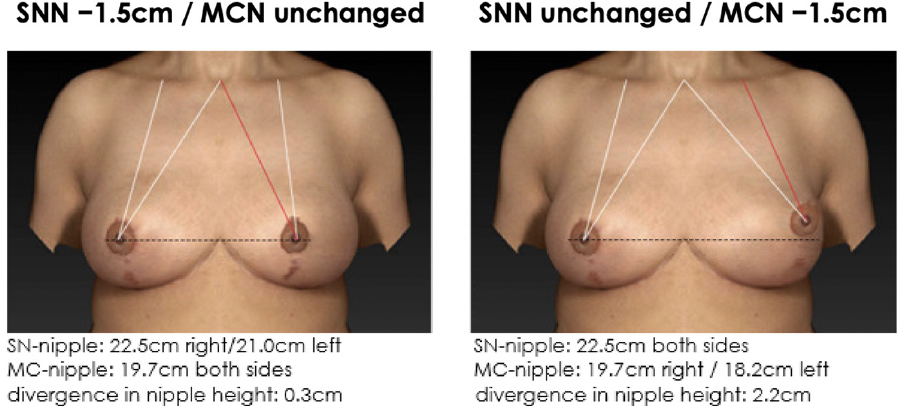
Figure 9. Non-symmetrical mirrored computer-simulated breast models with a modified MC-to- nipple distance and an SSN-to-nipple distance of +1.5 cm. In total, 78% of the plastic surgeons and 69% of the patients find the image with the unaltered MC-to-nipple distance more attractive than the image with the unaltered SSN-to-nipple distance.